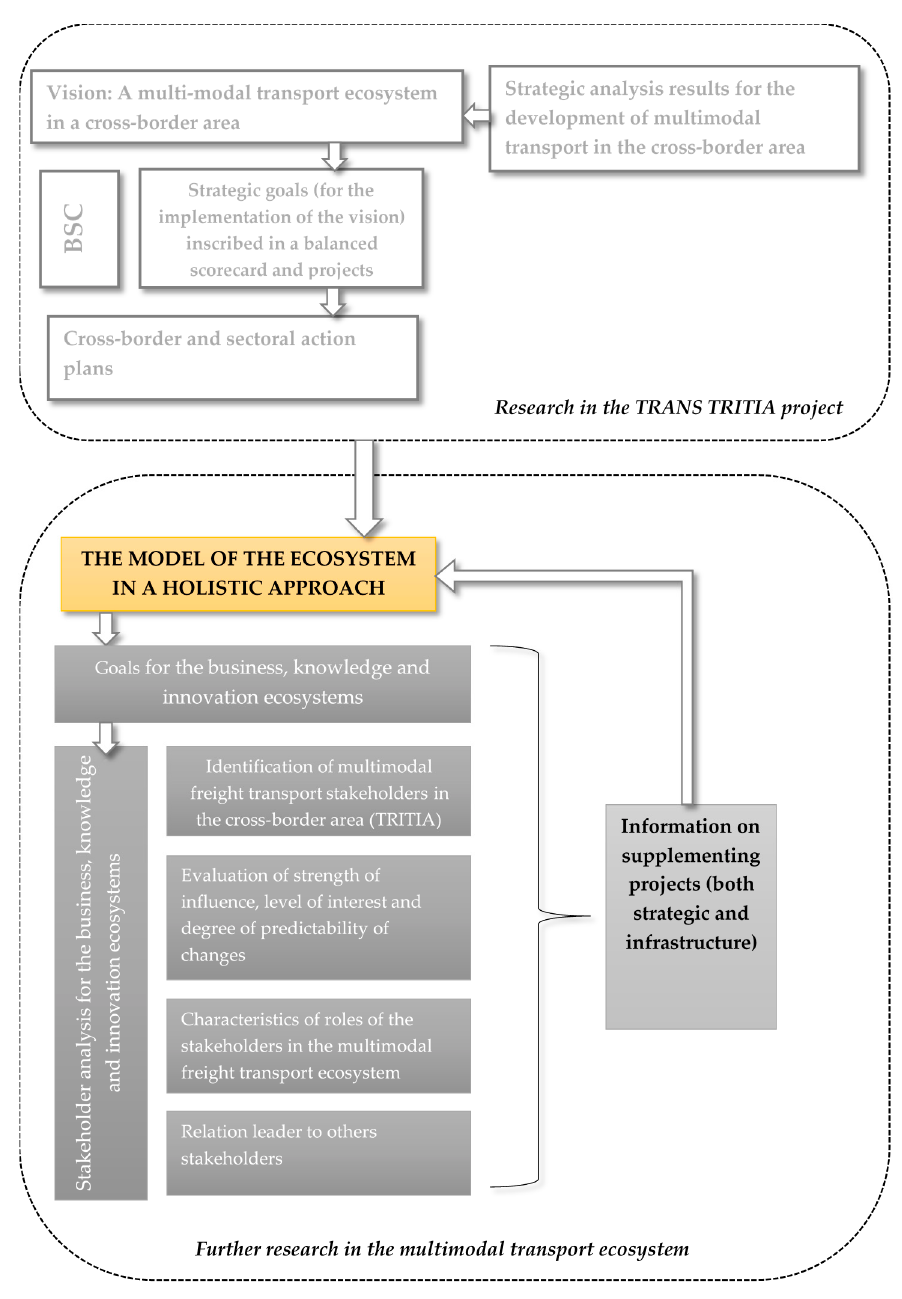
Figure 1. Research methodology (own study).